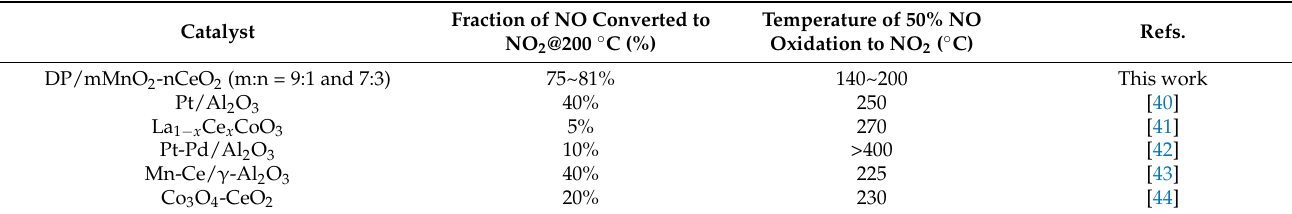
Table 6. Properties of metal-oxide- and perovskite-type catalysts for NO oxidation. Fraction of NO Converted to Temperature of 50% NO Catalyst NO 2 @200 ◦ C (%) Oxidation to NO 2 ( ◦ C)